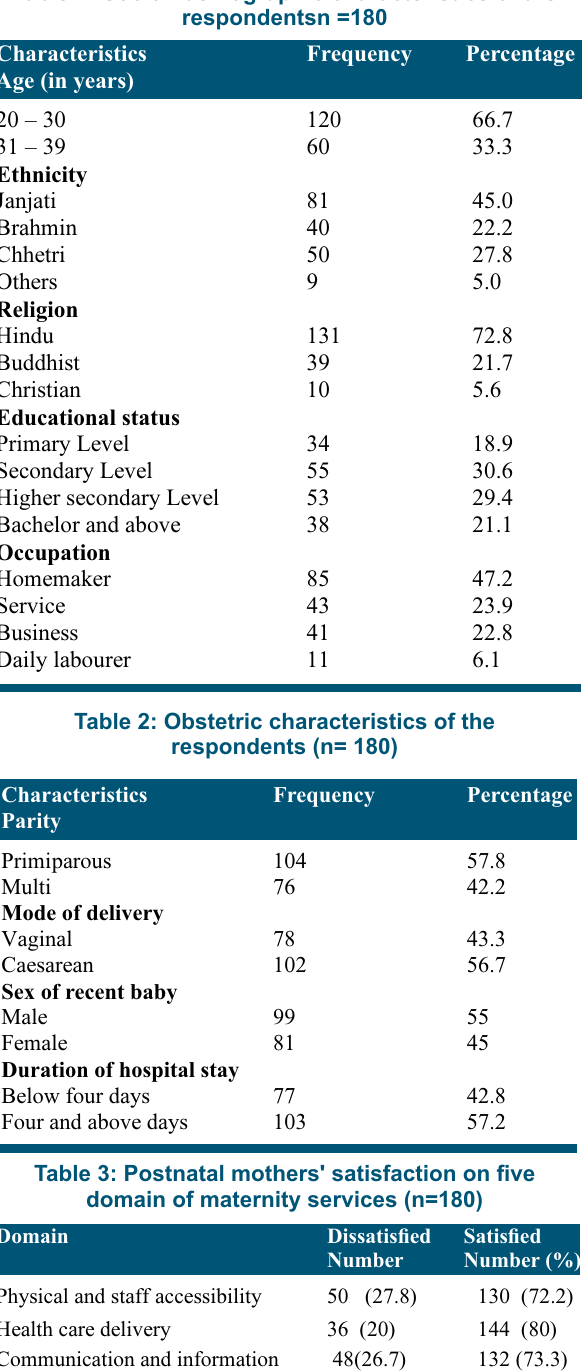
Table 1: Socio - demographic characteristics of the